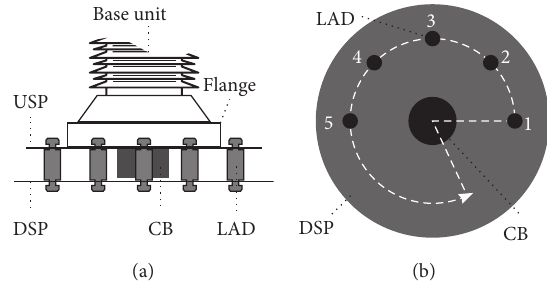
Figure 2: Schematic diagram of the seismic isolation device: (a) lateral view, (b) plan view. Top flange